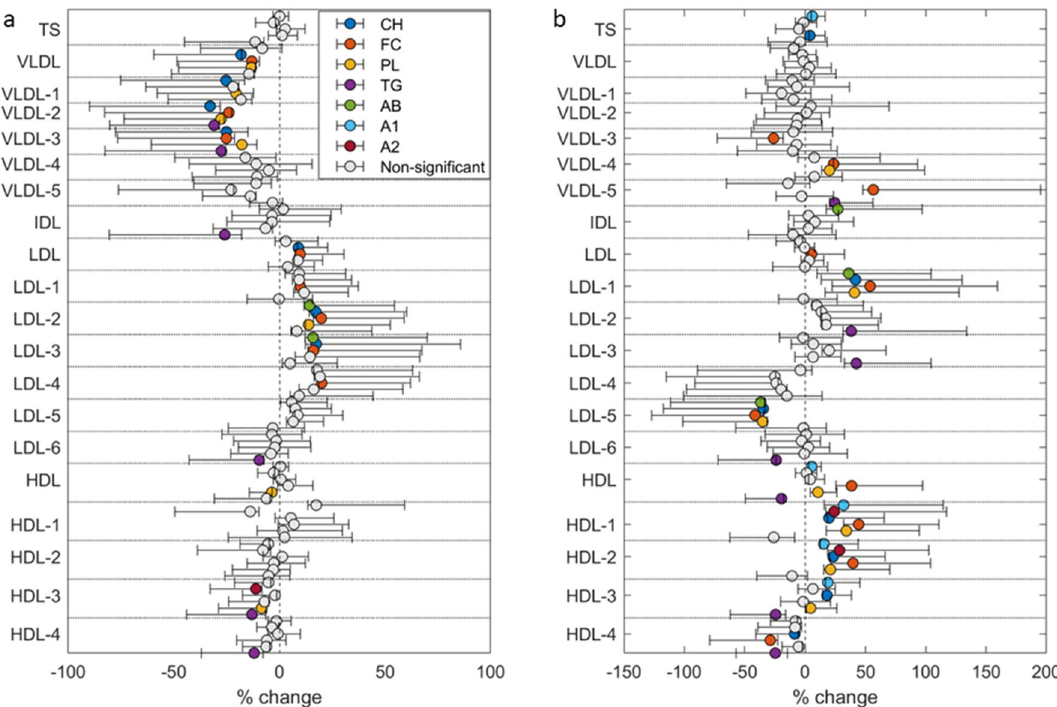
Figure 3. Change in lipoprotein subfractions from baseline to after 5 days of high-fat diet. In ( a ) fasted samples, and ( b ) postprandial samples. Symbols show median percentage change and error bars show interquartile range. TS = total serum, VLDL = very low-density lipoprotein, IDL = intermediate-density lipoprotein, LDL = low- density lipoprotein, HDL = high-density lipoprotein, CH = cholesterol, FC = free cholesterol, PL = phospholipids, TG = triglycerides, Apo-B = apolipoprotein B100, Apo-A1 = apolipoprotein A1, Apo-A2 = apolipoprotein